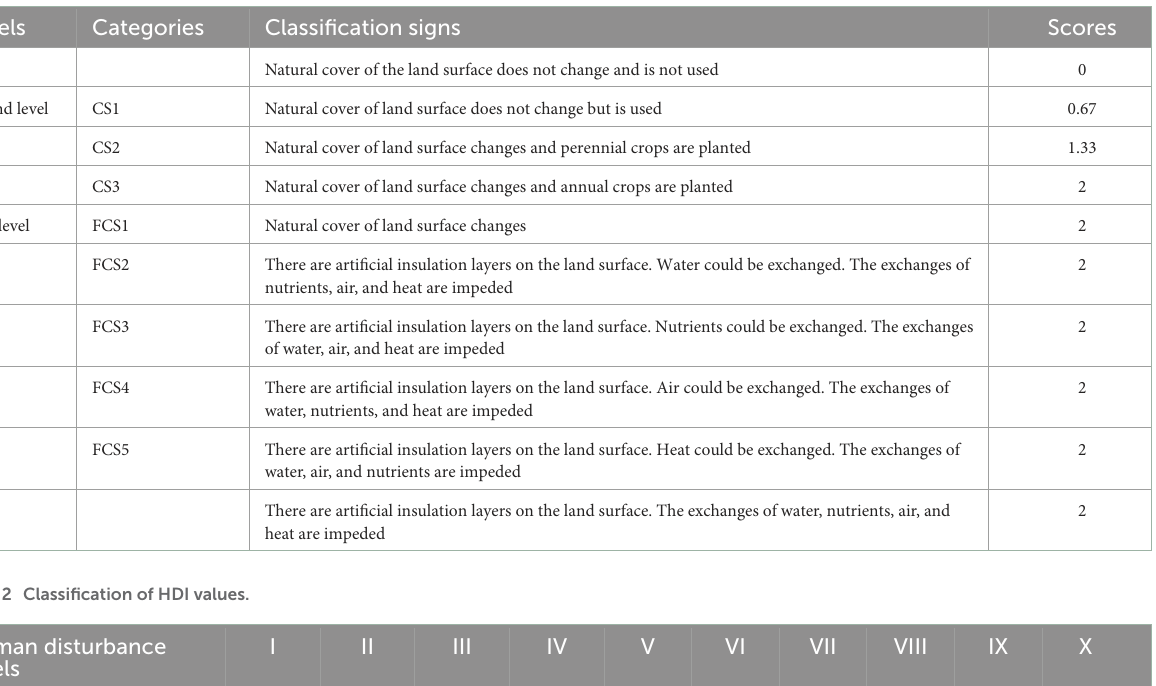
TABLE 1 Classification of land use naturalness. Levels